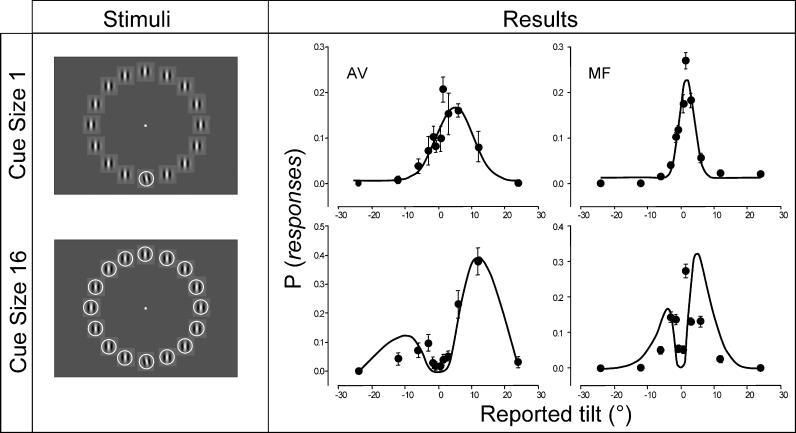
Stimuli and Response Distributions of the Partial Cueing ExperimentThe left panels show examples of the stimuli used. In the cue size 1 condition (top left panel), 16 elements were displayed and a 2-pixels-thick outlining circle of 1.5° diameter precued (100% valid) the target location, which was randomly set trial by trial. In the cue size 16 conditions, all the patch stimuli were precued. The other four panels show the response distributions for target tilts around threshold for two naive observers, AV (middle panels) and MF (left panels), for the two cueing conditions. The circles represent the proportion of reported responses for each response probe, while the error bars show an estimate of standard error of the means computed by a bootstrap [30] procedure with 1,000 iterations. Although the display has drastically changed, the pattern of results is strictly consistent with that reported inFigures 3 and5, suggesting that the main effect of this study is not due to sensory interactions, or “crowding,” among abutting stimuli.